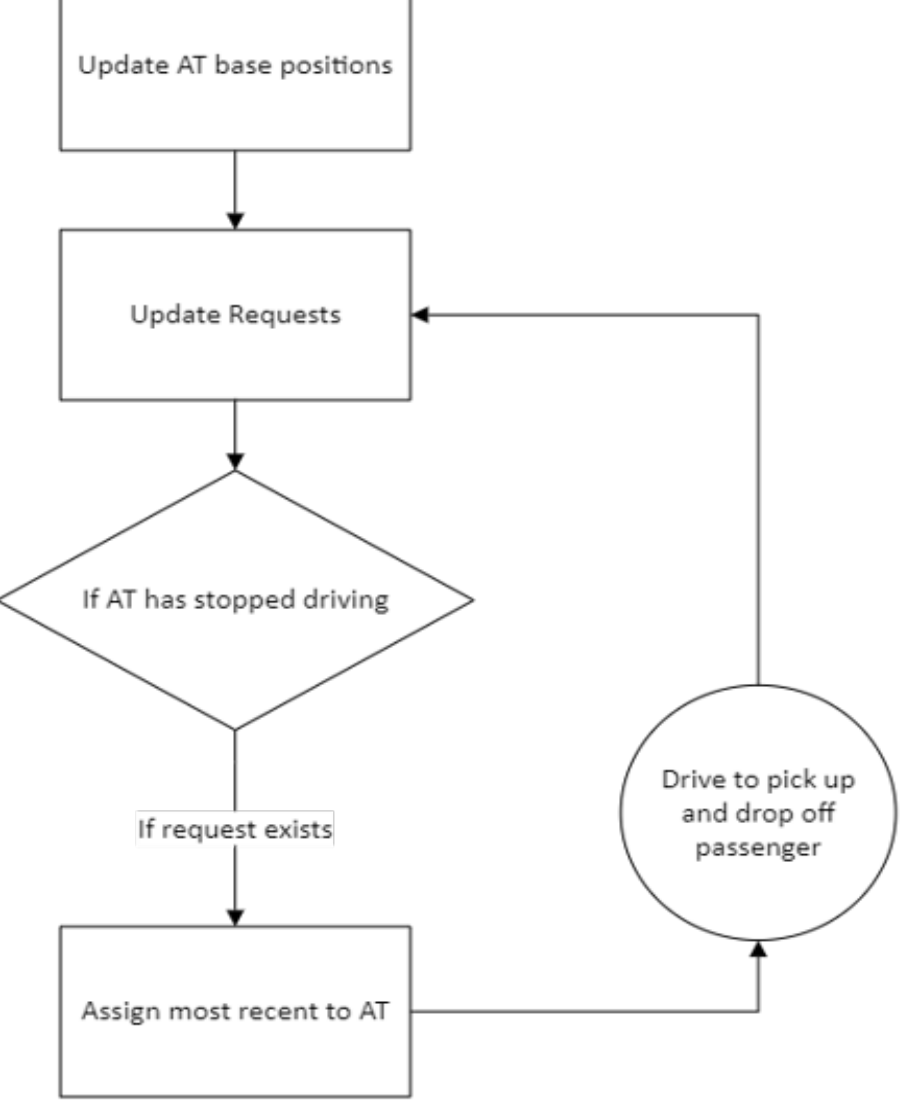
Figure 19. First-come, first serve SAV dispatcher.